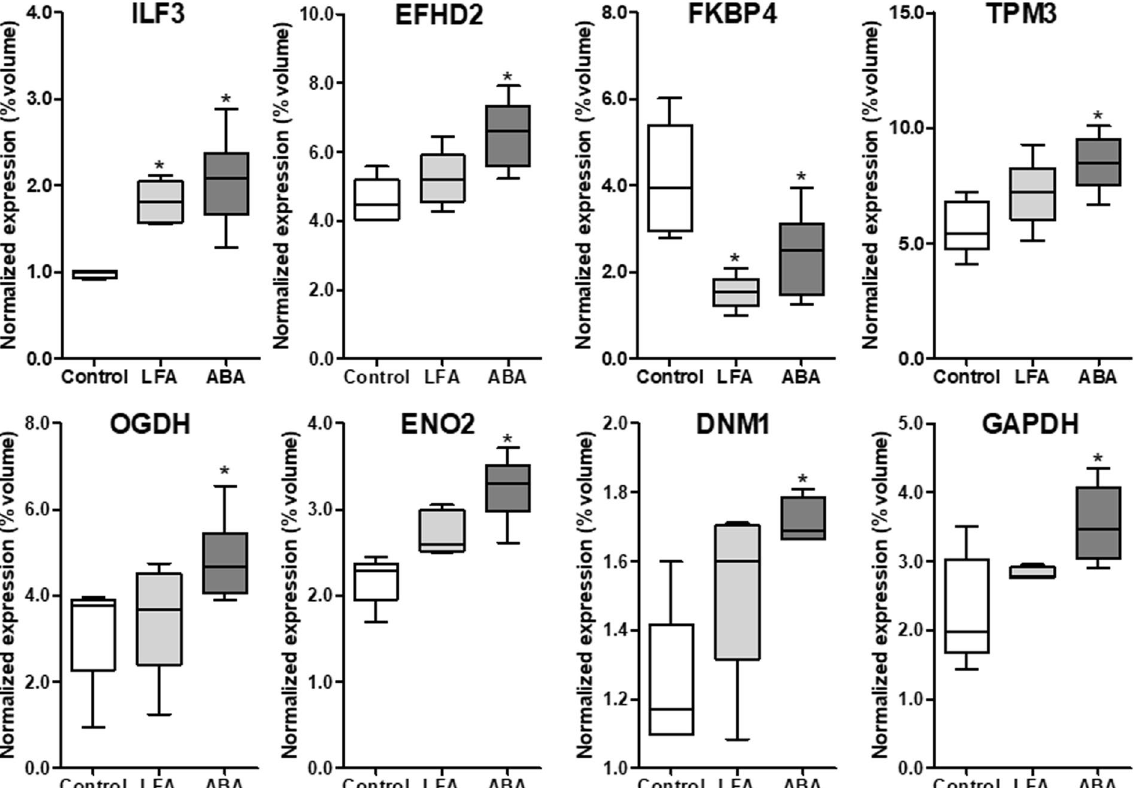
Figure 3. Hypothalamic proteins differentially expressed at day 17. Eight differently modulated proteins were identified at d17 (n = 6/group). * p < 0.05 vs Control. ILF3: Interleukin enhancer-binding factor 3; EFHD2: EF- hand domain-containing protein D2; FKBP4: Peptidyl-prolyl cis-trans isomerase; TPM3: Tropomyosin alpha-3 chain; OGDH: 2-Oxoglutarate dehydrogenase, mitochondrial; ENO2: Gamma-enolase; DNM1: Dynamin-1; GAPDH: Glyceraldehyde-3-phosphate